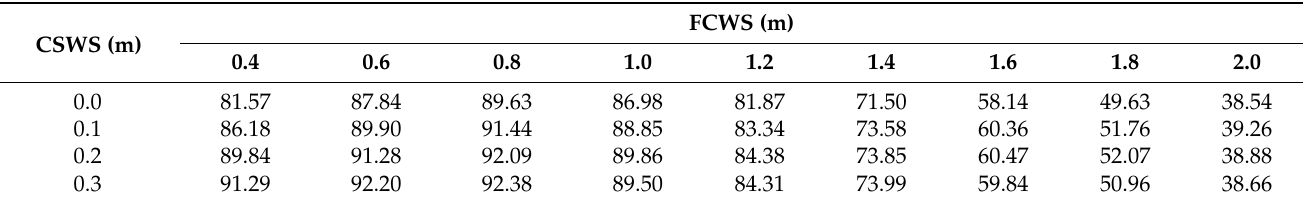
Table 4. The influence of different combinations of CSWS and FCWS on the F 1 score (%) of C. equisetifolia detection.